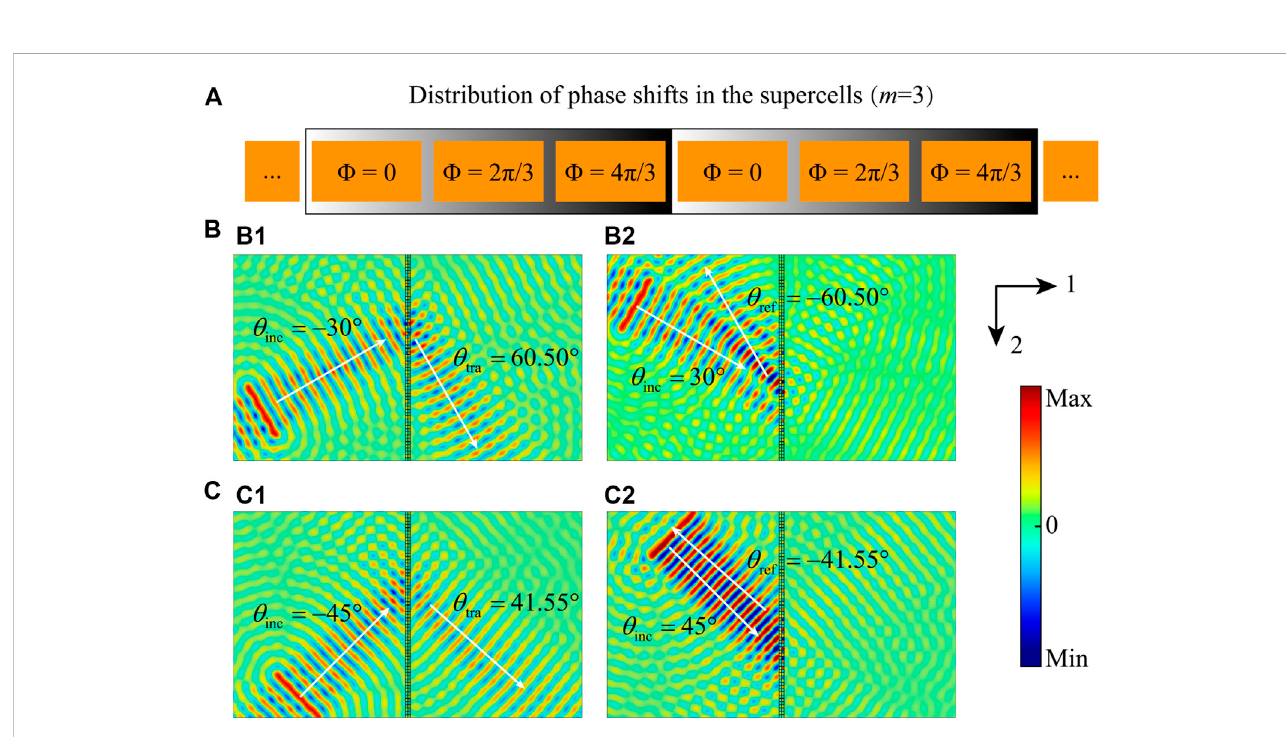
FIGURE 5 (A) Distribution of phase shifts along the supercell with m = 3. Out-of-plane displacement fi elds of (B) ± 30 ° and (C) ± 45 ° incident